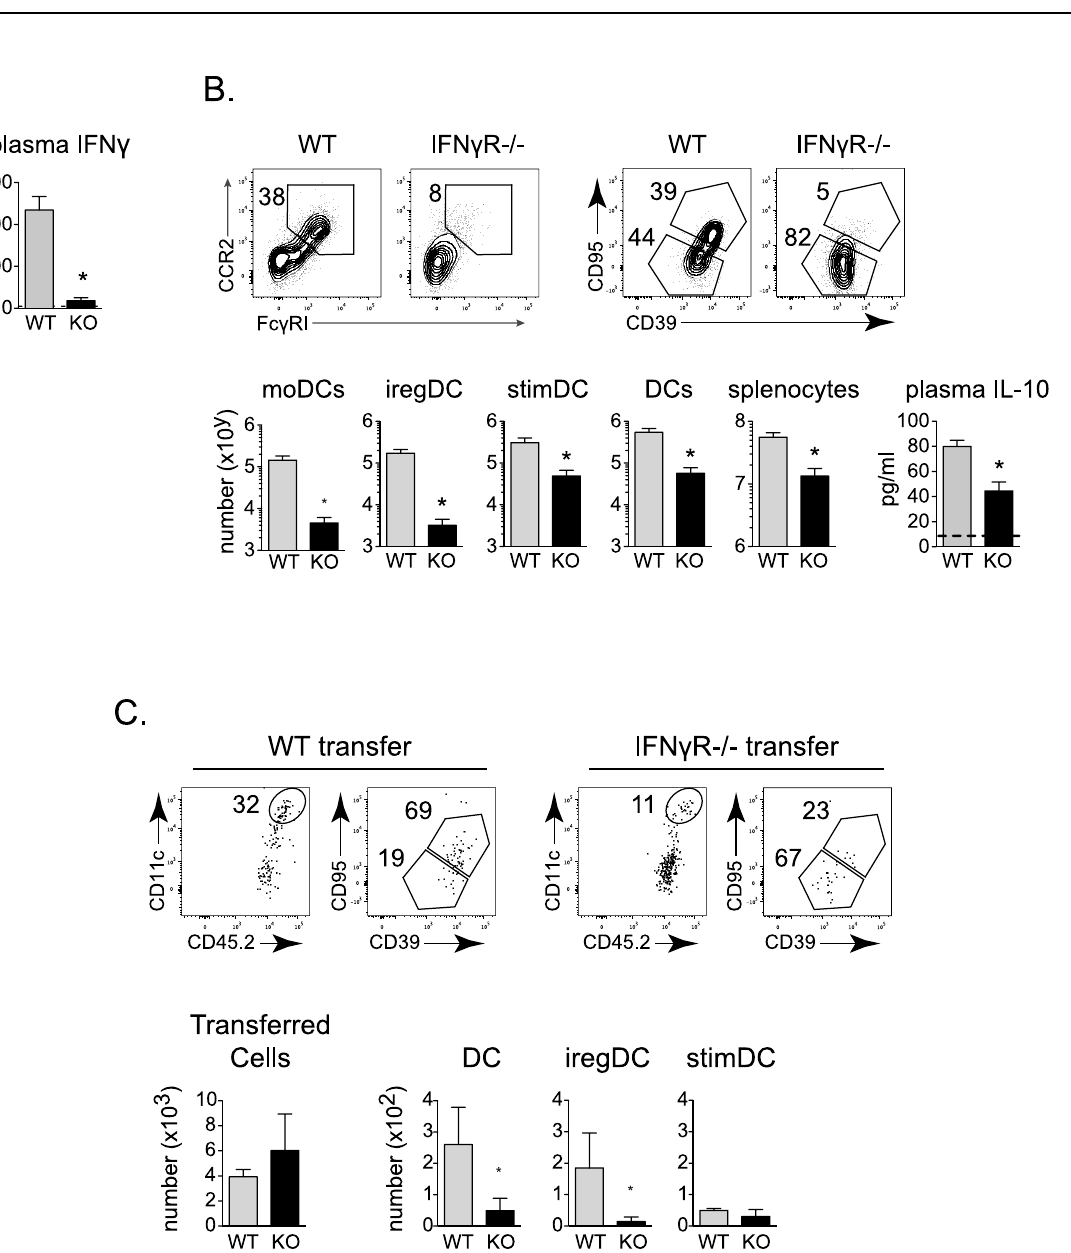
Fig 6. Monocytes require direct IFN γ R signaling for DC differentiation throughout persistent virus infection. A. Plasma IFN γ concentration in WT and MyD88-/- (KO) mice at day 9 after LCMV-Cl13 infection. B. Flow plots represent the percent of moDC, iregDC and stimDC (gated on total CD11b+ CD11c + DC) on day 9 in LCMV-Cl13 infected WT and IFN γ R-/- mice. Bar graphs indicate the number of moDC, iregDC, stimDC, total CD11b+ DC, total splenocytes and plasma IL-10 concentration in WT and IFN γ R-/- mice at day 9 after LCMV-Cl13 infection. C. WT and IFN γ R-/- na ï ve monocytes were transferred into LCMV-Cl13 infected WT mice and gated and analyzed as in Fig 4E. Flow plots show CD11c++ DC, and iregDC and stimDC development in WT (left flow plots) and IFN γ R-/- (right flow plots) transferred monocytes. Bar graphs indicate the total number of transferred cells at day 9 after infection and the number of CD11b+ DC, iregDC, and stimDCs derived from the transferred monocytes. Data are representative of 2 or more independent experiments each consisting of 3 – 5 mice per group. * , p <